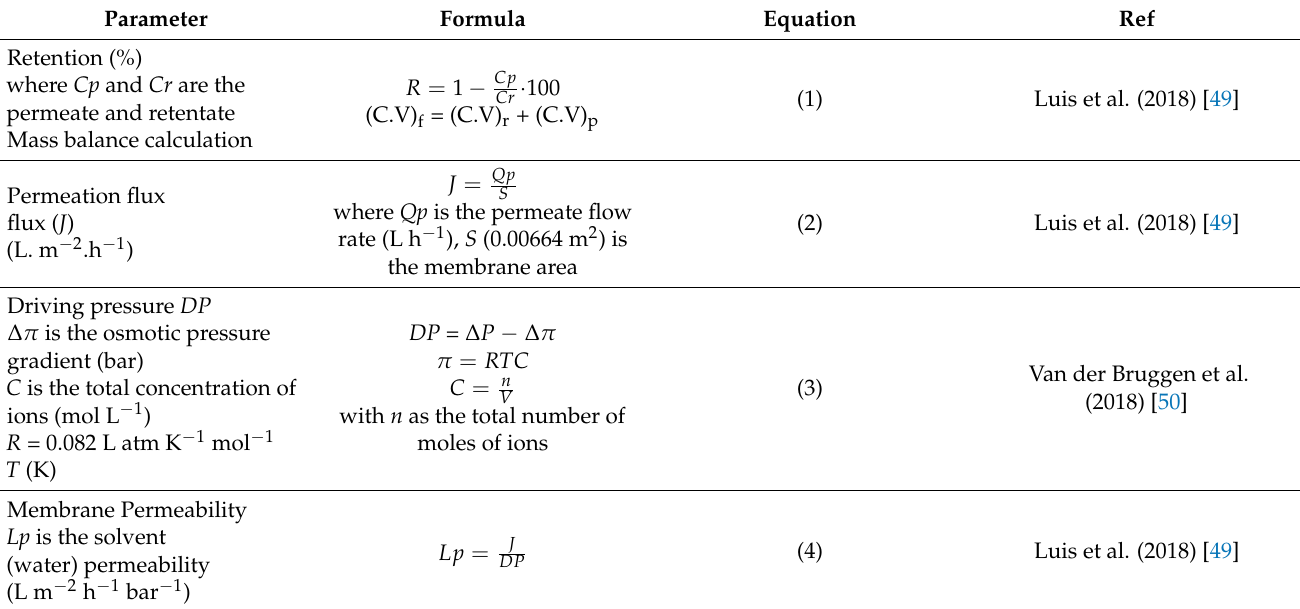
Table 4. Main parameters used to evaluate the performance of RO and NF